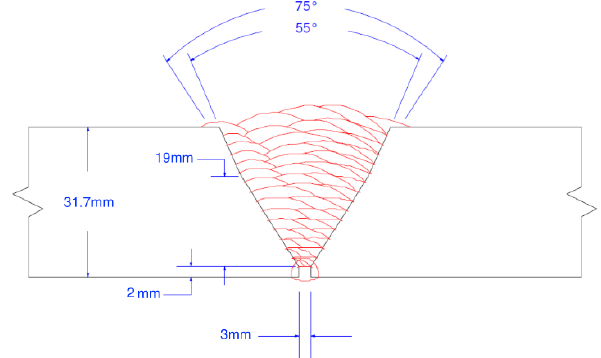
Figure 2. Illustration of the butt joint weld passes distribution.